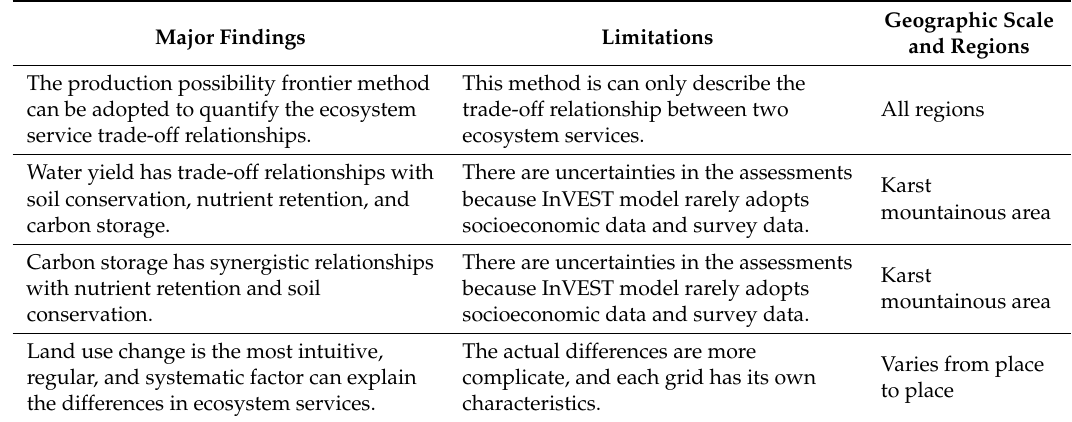
Table 1. Main findings of this